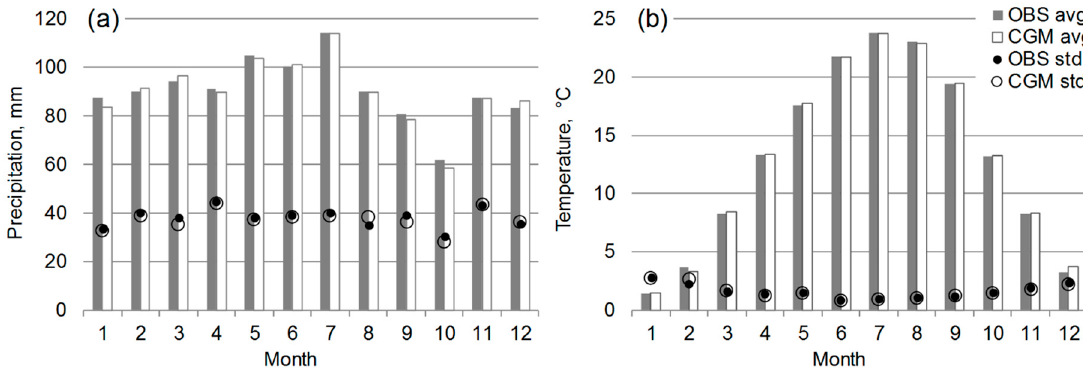
Figure 3. Comparison of Observed (OBS) and “Base” reproduced by the Conditional Generation Method (CGM) for ( a ) precipitation and ( b ) temperature. “avg” and “std” indicates the average and standard deviation, respectively.